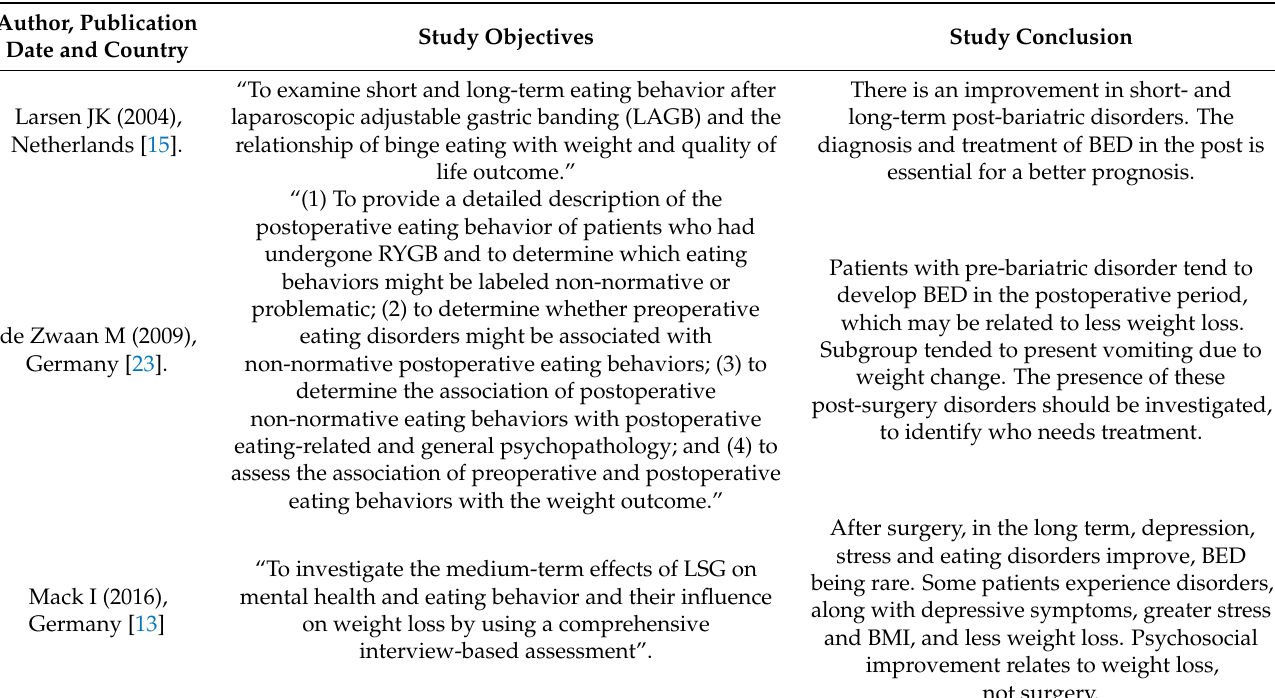
Table 2. Studies objectives and